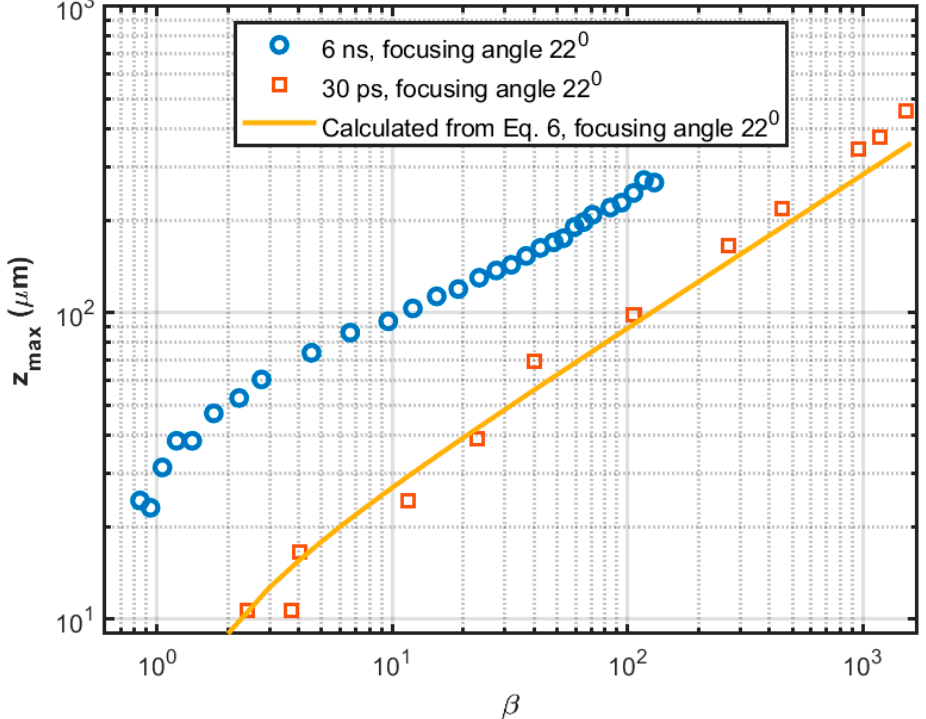
Figure 2. Comparison of the calculated plasma length using Equation (6) to the experimentally measured values in [55], while using 6 ns and 30 ps pulses with focusing angle 22° using 1064 nm Nd:YAG laser.